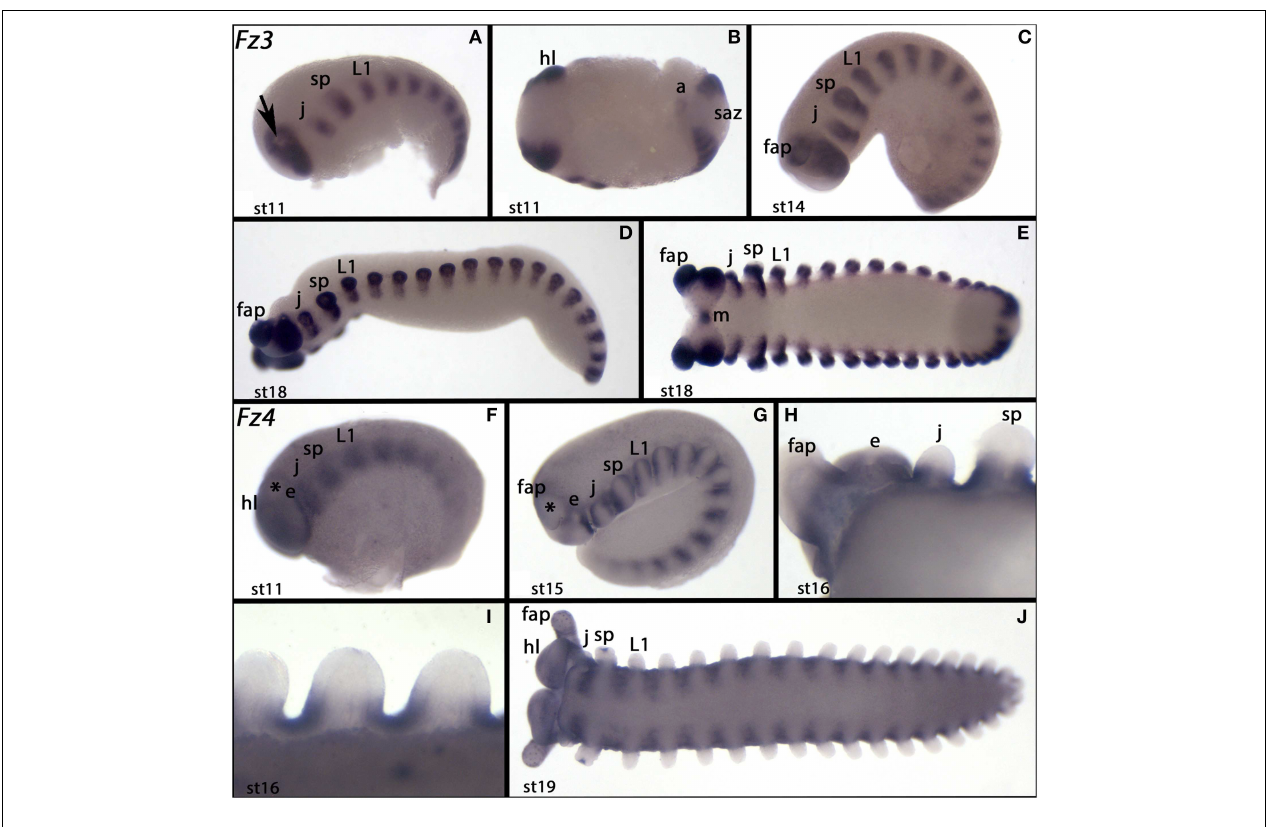
FIGURE 7 | Expression of Euperipatoides fz3 and fz4 . In all panels anterior is to the left. (A–E) Show expression of Ek-fz3 . (F–J) Show expression of Ek-fz4 . (B,E,I,J) Ventral views. (A,C,D,F,G) Lateral views. (H)